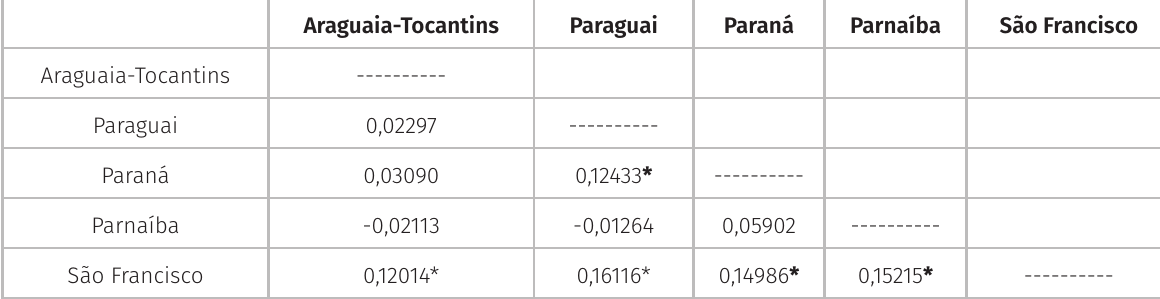
Table I. Pairwise fixation indices f ( F ) between the Antilophia galeata populations sampled in the gallery forests ST of the five hydrographic basins of the Cerrado.